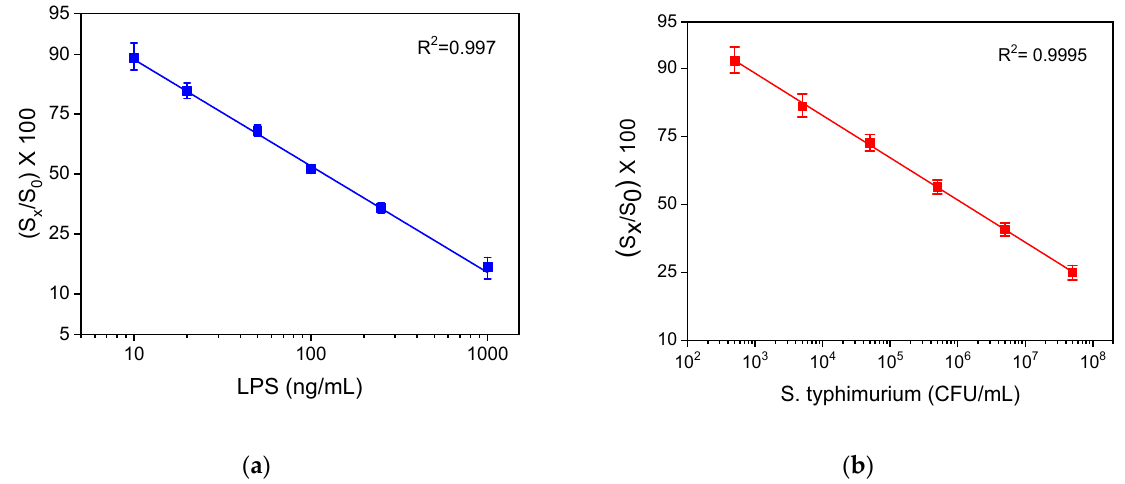
Figure 8. Typical calibration curves obtained for ( a ) LPS and ( b ) bacteria with the WLRS system applying the three-step assay configuration. Each point corresponds to the mean value of the signals obtained from three chips ± SD. For comparison reasons, the calibration curves obtained for LRS and whole